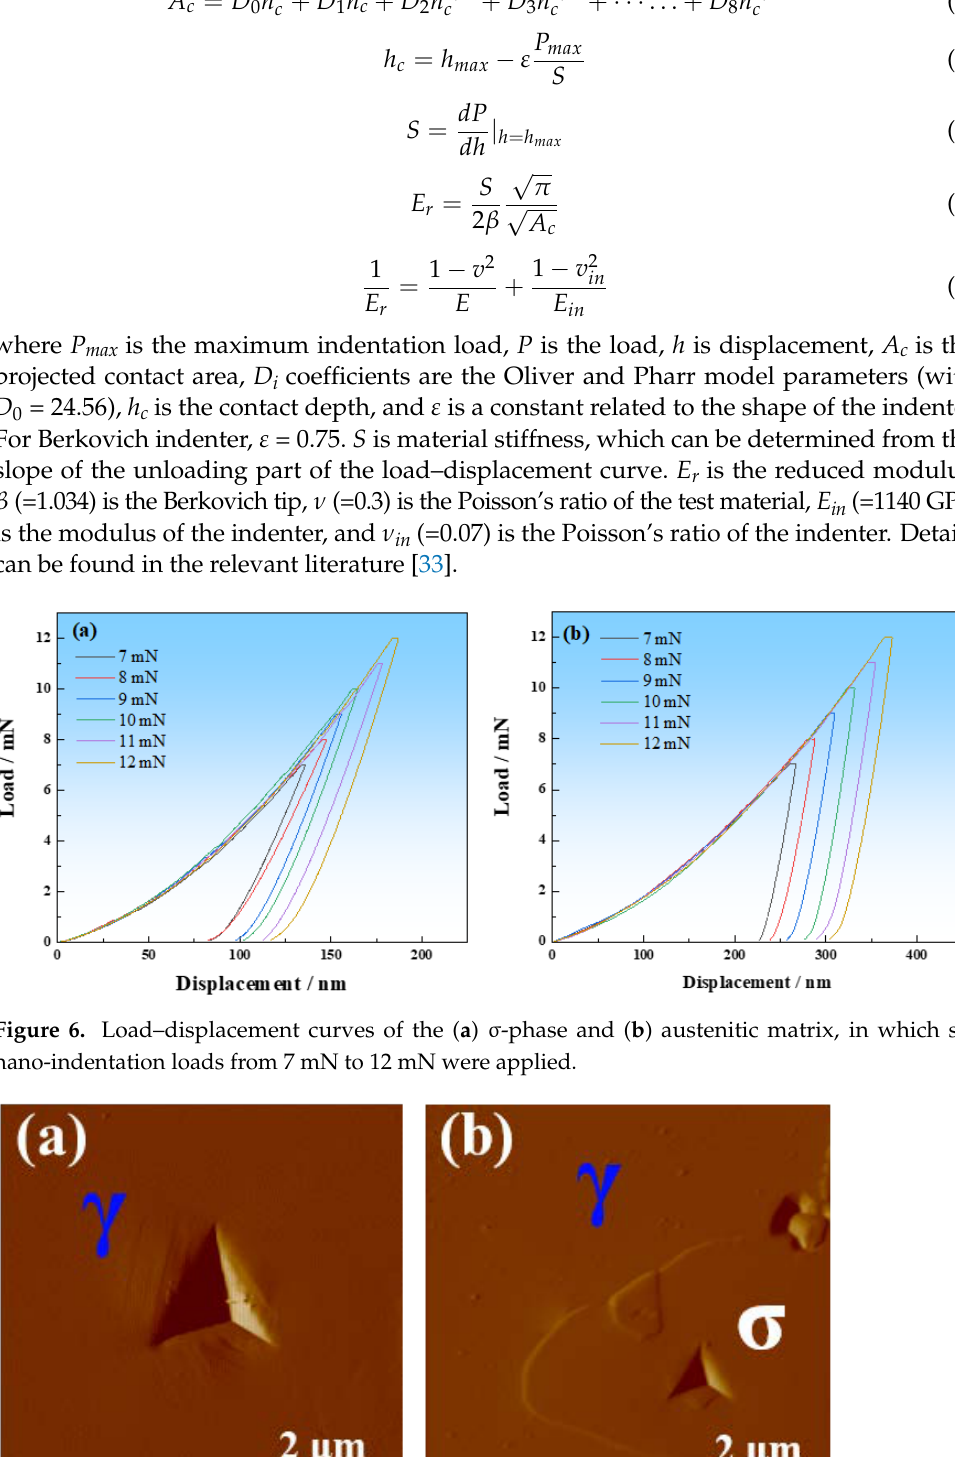
Figure 7. Impression in situ SPM images in the ( a ) austenitic matrix and ( b ) σ -phase.